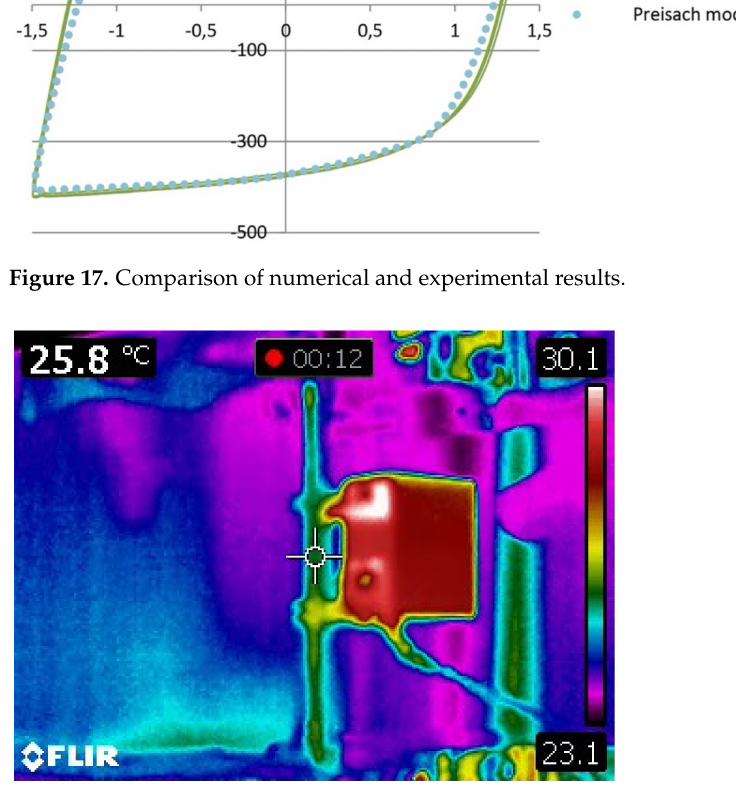
Figure 18. Thermographic recording of the temperature of the